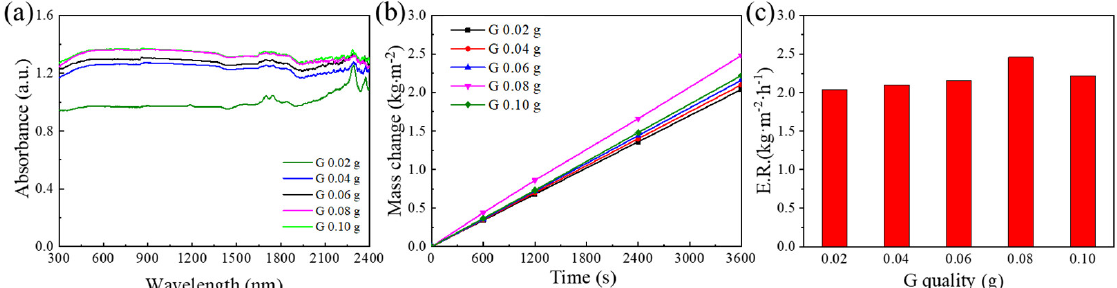
Figure 3. ( a ) UV − vis NIR absorption spectra; ( b ) Evaporation mass variation; ( c ) Evaporation rates of photo − thermal layers with different graphene